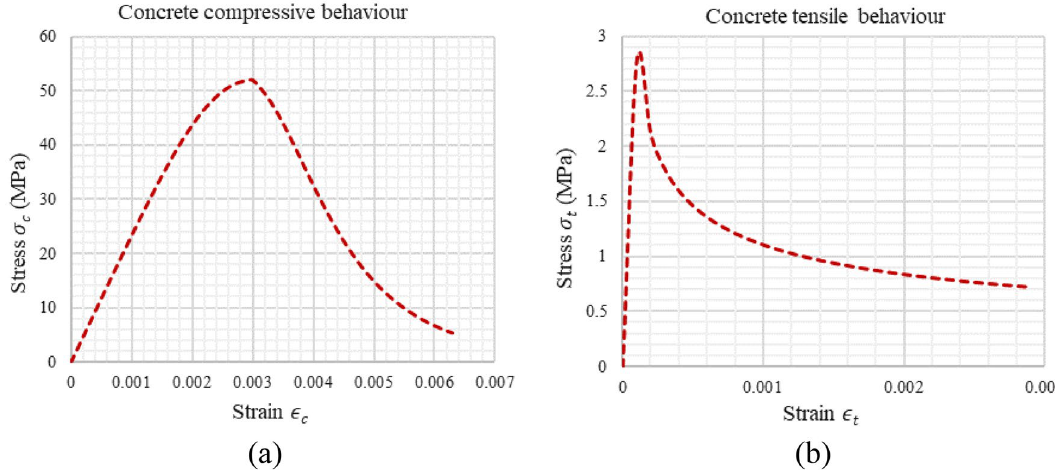
Figure 1. Experimental properties of concrete in: ( a ) Compression, ( b )